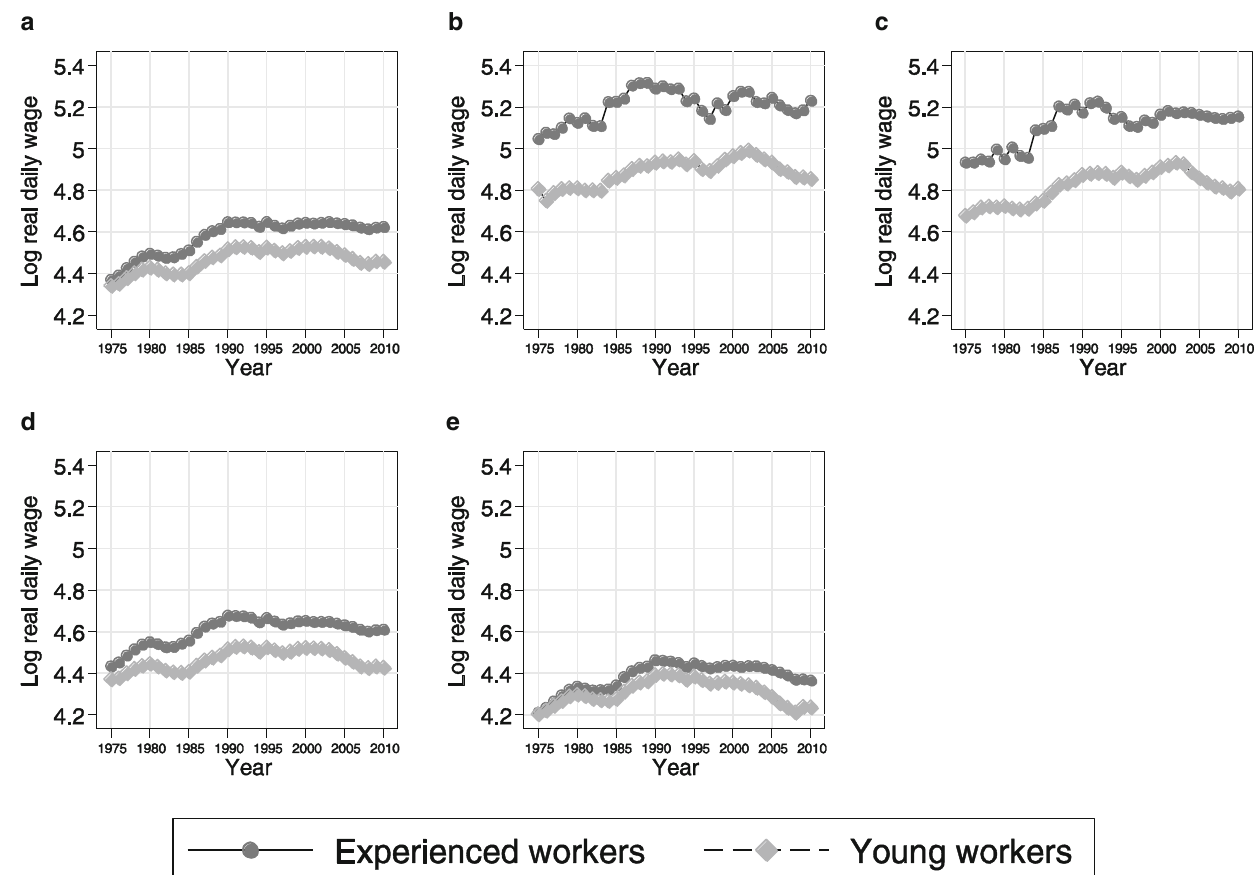
Fig. 2 Median Log Real Daily Wages of Experienced Workers and of Young Workers (1975–2010) (Source: 2% IABS Sample for full-time workers. N = 7,182,868 for experienced workers (36 to 60 years) and N = 3,752,250 for young workers (25 to 35